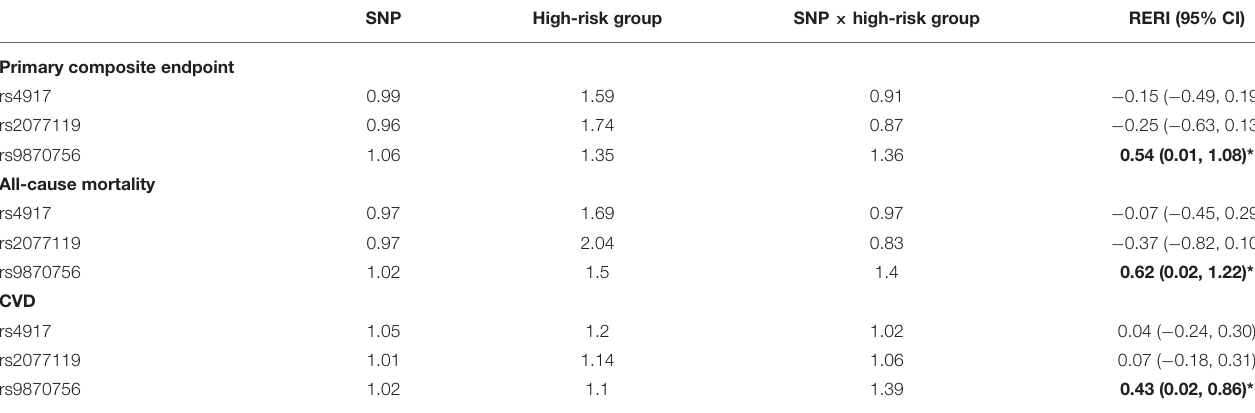
TABLE 4 | Additive interaction between SNPs and high-risk